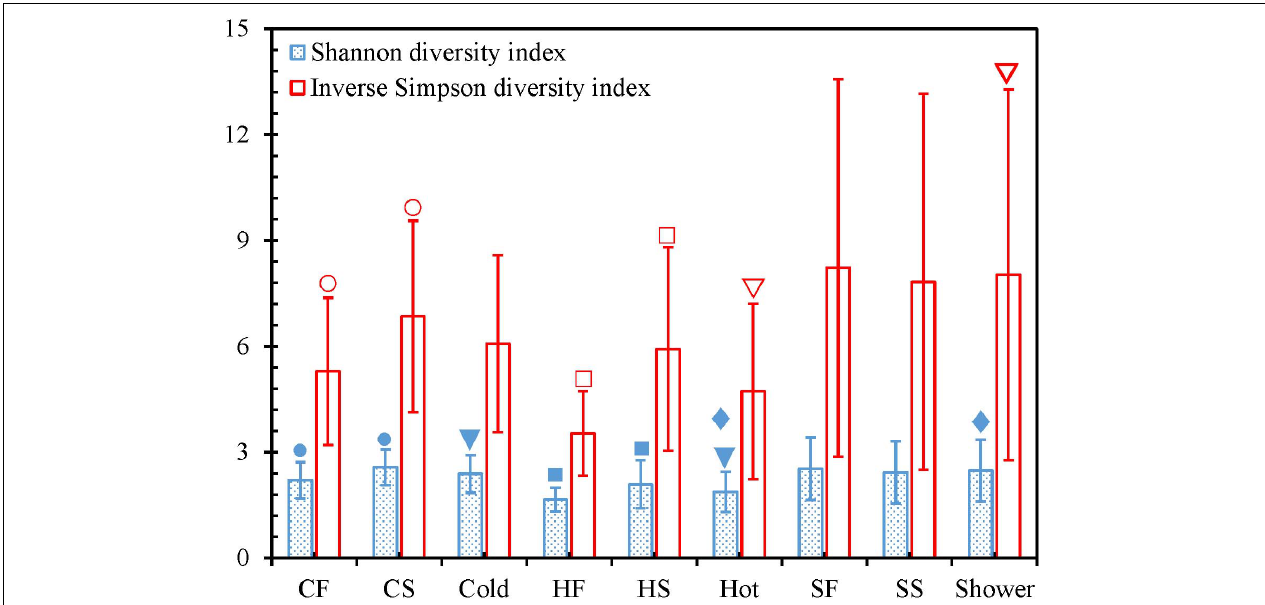
FIGURE 4 | Shannon and Inverse Simpson diversity indices. CF : Cold tap water-First draw. CS : Cold tap water-Second draw. Cold : Cold tap water. HF : Hot tap water-First draw. HS : Hot tap water-Second draw. Hot : Hot tap water. SF : Shower water-First draw. SS : Shower water-Second draw. Shower : Shower water. Column heights: Arithmetic means. Error bars: Standard deviations ( n = 16 for CF , CS , HF , HS , SF , and SS . n = 32 for Cold , Hot , and Shower ). We used Mothur to calculate the indices for each water sample and SPSS R (cid:13) to determine whether the differences of the indices for each of the following pairs were statistically significant: CF versus CS , HF versus HS , SF versus SS , Cold versus Hot , Cold versus Shower , and Hot versus Shower . A pair of indices marked with the same symbol are significantly different ( p < 0.05).